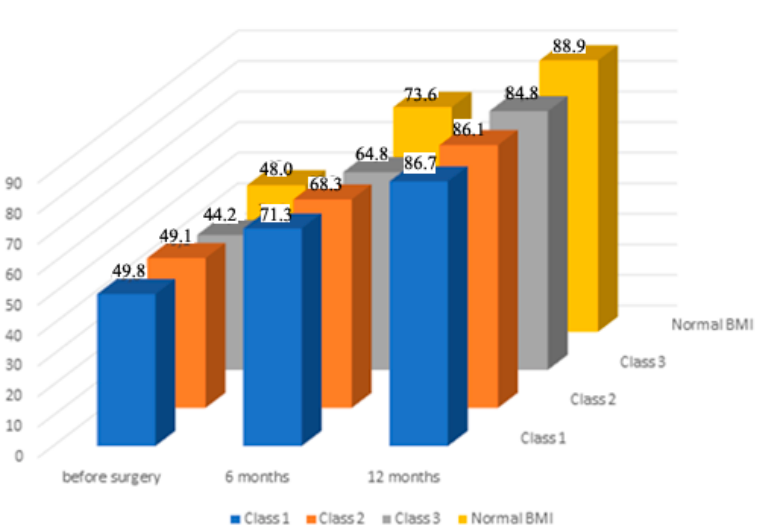
Figure 1. Stage 1—dynamics of functional results by Harris hip score (HHS) before and after sur- gery.